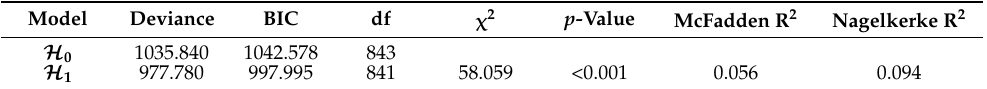
Table 9. Summary of the logistic model characterizing the relationship between the variable Y 2 : “Have you taken COVID-19 treatment?” and the variables X 1 and Z 1 (Model 3).